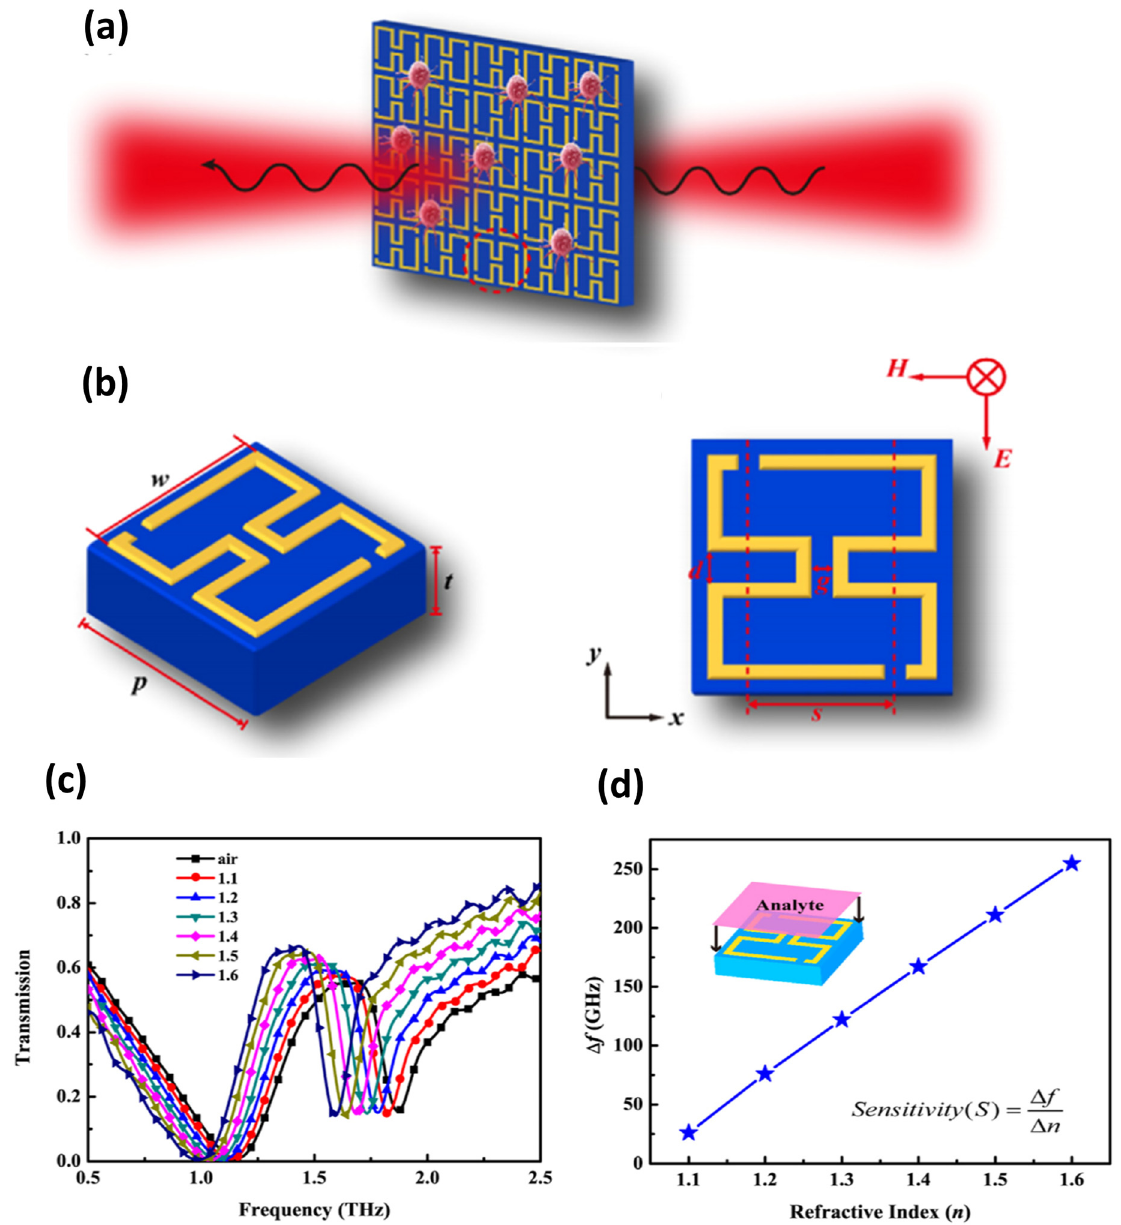
Figure 9: Oral cancer cells (HSC3) apoptosis detection with electromagnetically induced transparency like metasurface. (a) Schematic of the electromagnetically induced transparency like (EIT-like) based metasurface. (b) Metasurface structure with symmetry- breaking double-splits ring resonators. (c) Modeling the transmission curve for different refractive index (1 – 1.6 RIU). (d) Frequency shift response curve for different refractive indices. (e) and (f) Measurement results for the different dosage of cisplatin. (g) and (h) Cancer cells response against time for the anti-cancer drug. Experimental results show that the metasurface provides a sensitivity of 900 kHz/cell ml − 1 . (a) – (h) Reproduced with permission from Yan et al., Biosens. Bioelectron. 126 , 485 – 492 (2019) [148]. Copyright 2019